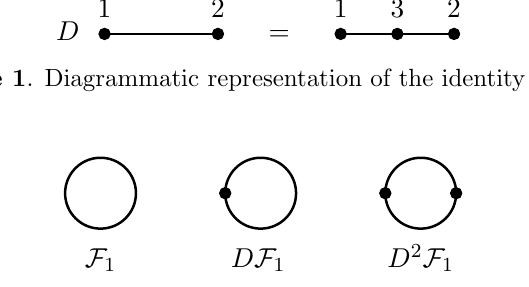
Figure 2 . Feynman diagrams for